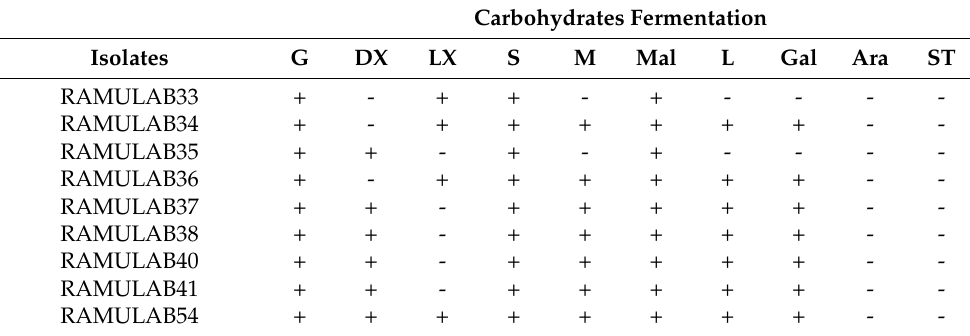
Table 3. Fermented sugarcane juice isolates carbohydrate fermentation assay.